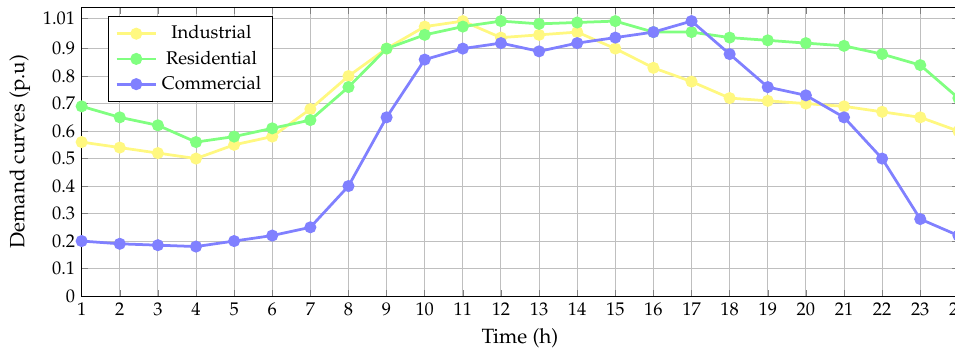
Figure 4. Type of load: residential, commercial, and industrial curves. Table 2. Types of load profiles